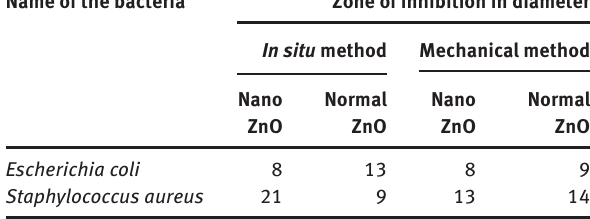
Table 1 Zone of inhibition of the emulsions.